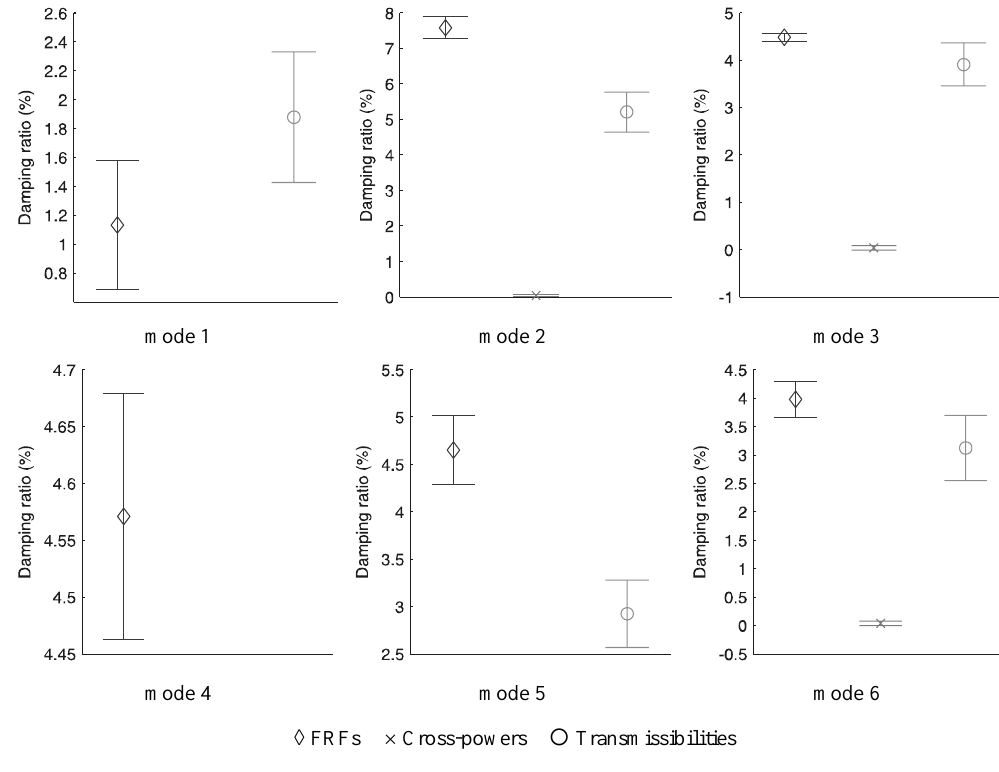
Fig. 21. Results of cluster analysis: damping